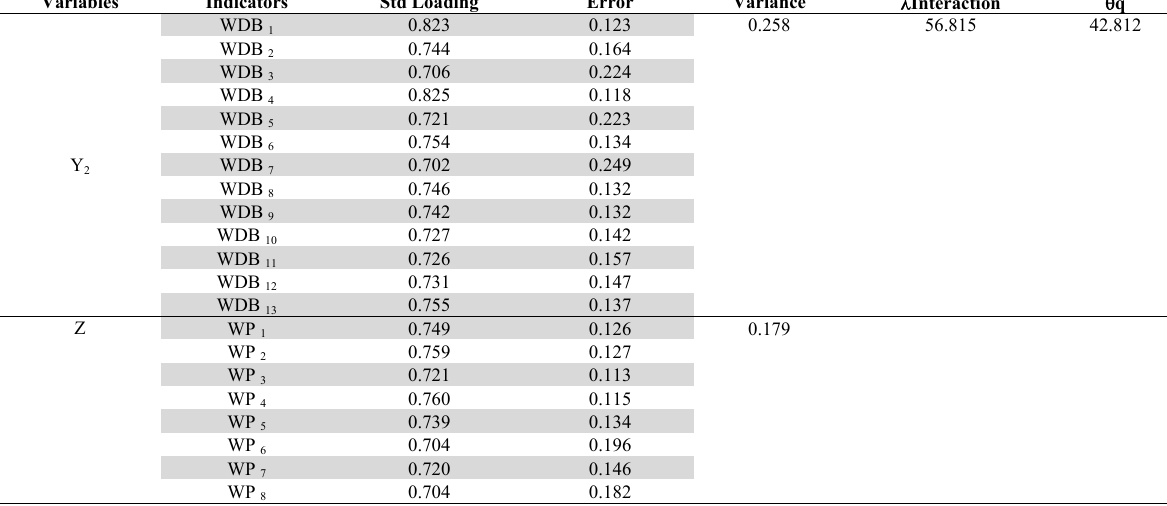
Results of Counting  and  q Variable Interaction; Workplace Deviant Behavior and Work Passion Behavior (Y 2 Z) Variables Indicators Std Loading Error Variance